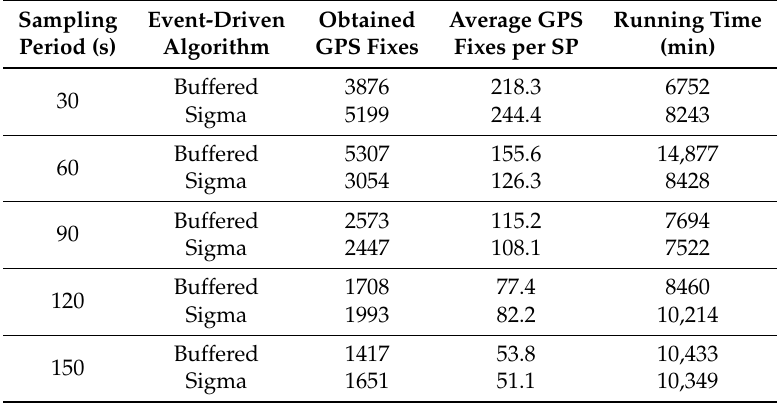
Table 1. Summary of results of first experiment (SP = stay